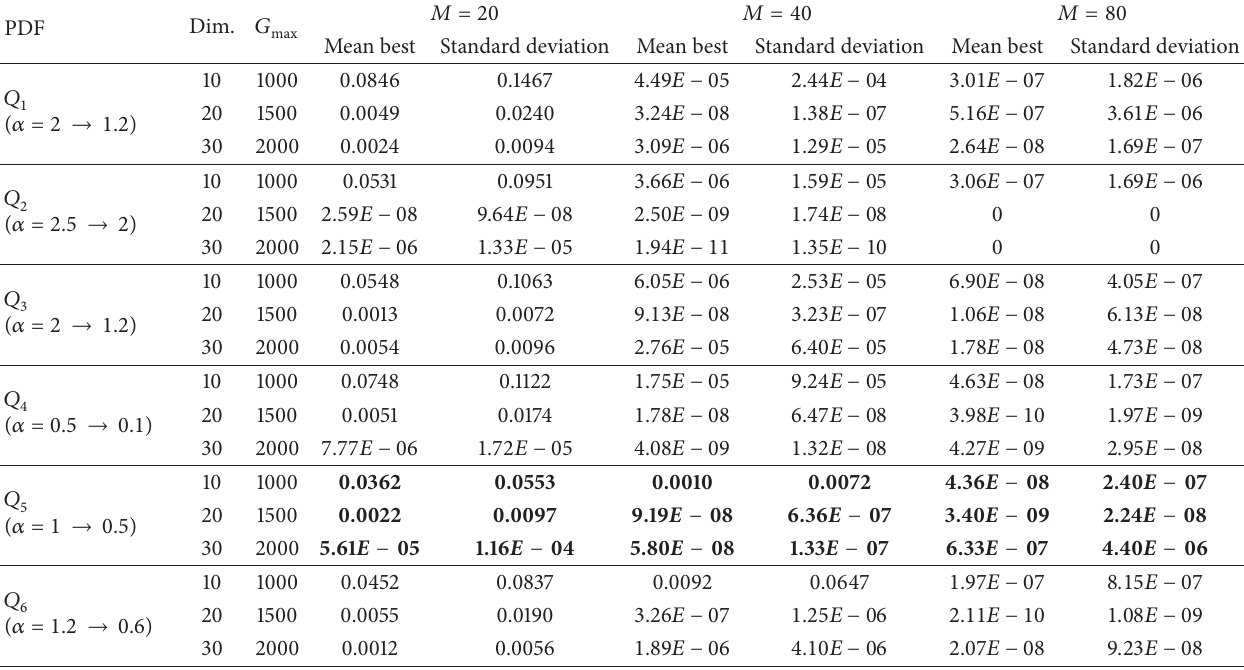
Table 5: Mean best fitness values and standard deviation for the generalized Griewank function.